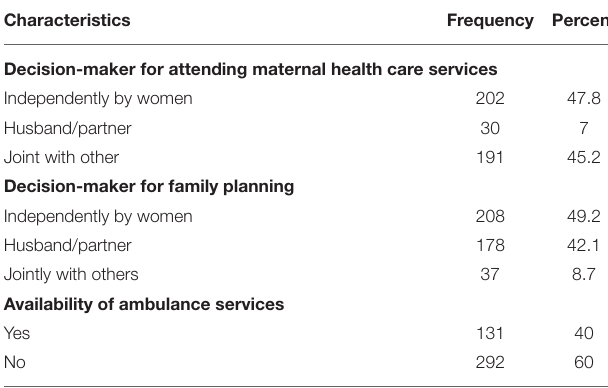
TABLE 2 | Health care service-related factors of pregnant women in Debremarkos city, northwest